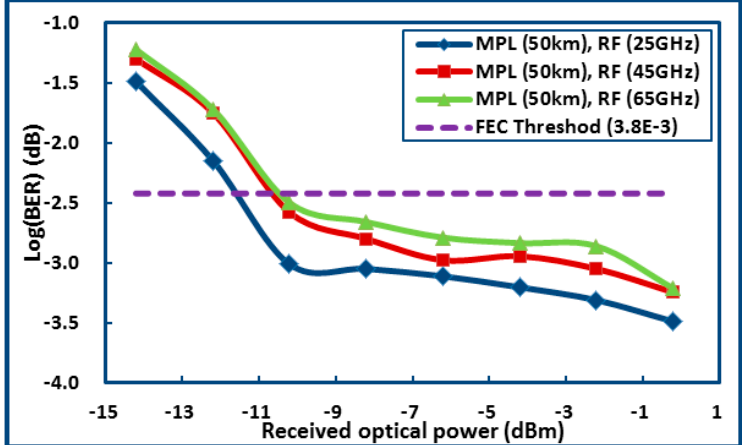
Figure 16. Relational curve between received optical power (ROP) and bit error rate (BER) in the downlink.